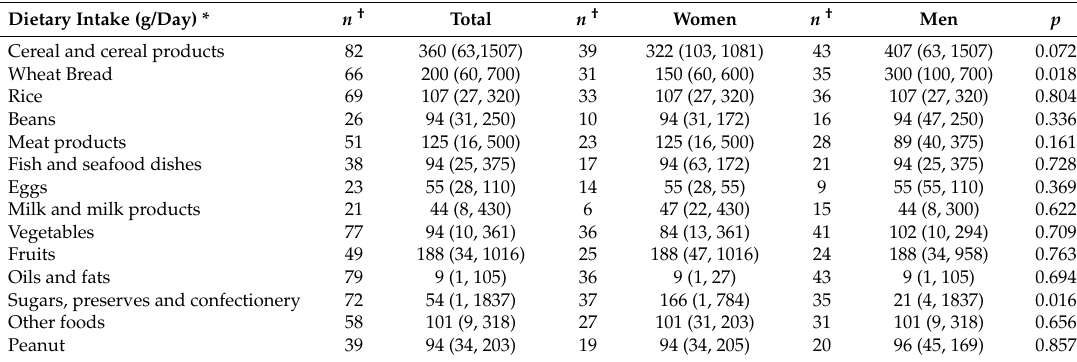
Table 2. Dietary intake of the studied sample, overall and by sex.